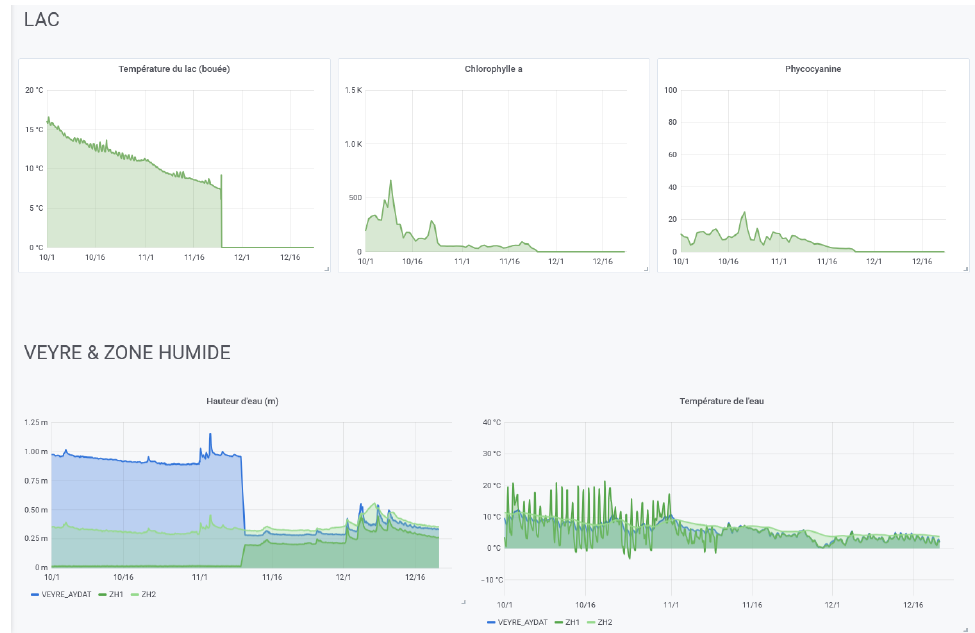
Figure 12. Extract of the dashboard of multiple independent sources—courtesy of Aydat Observatory.